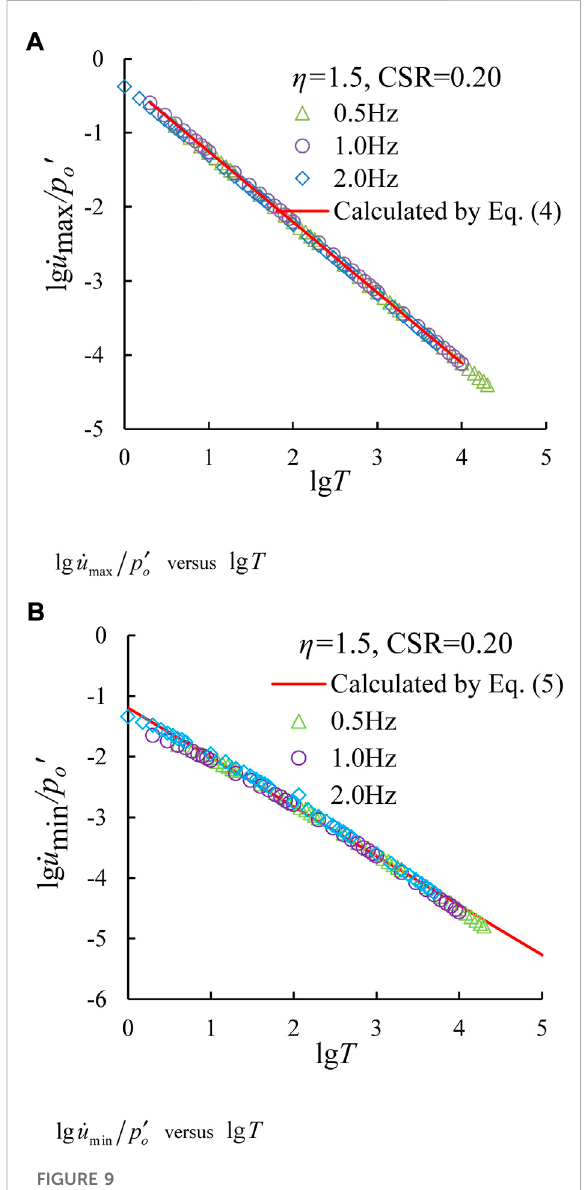
FIGURE 9 Relationships between lg _ u max / p ′ o and lg _ u min / p ′ o versus lg T under different f values for η = 1.50 and CSR = 0.20. (A) lg _ u max / p ′ o versus lg T and (B) lg _ u min / p ′ o versus lg T